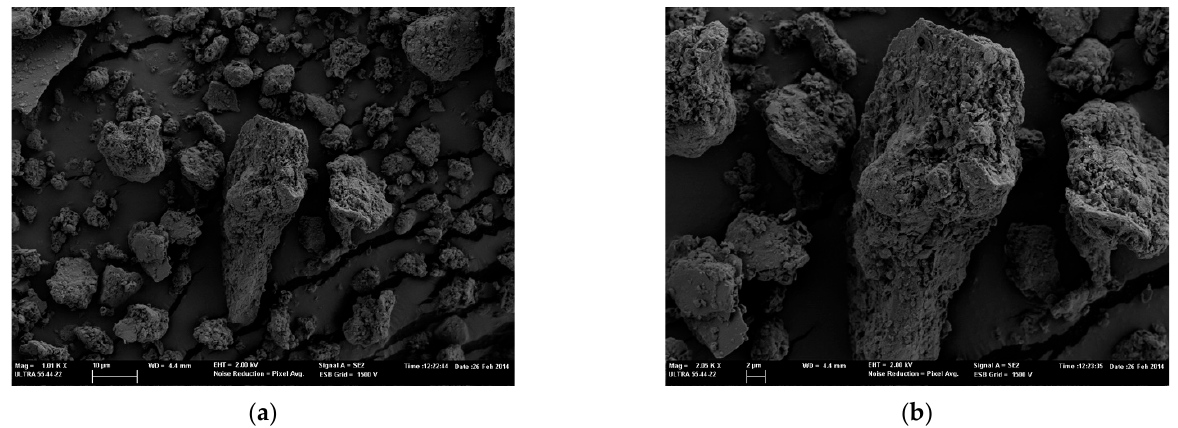
Figure 2. FESEM images of MMT K10 microparticles. ( a ) At 500× magnification and ( b ) at 2000× Figure 2. FESEMimagesofMMTK10microparticles. ( a )At500 × magnificationand( b )at2000 × magnification. magnification.